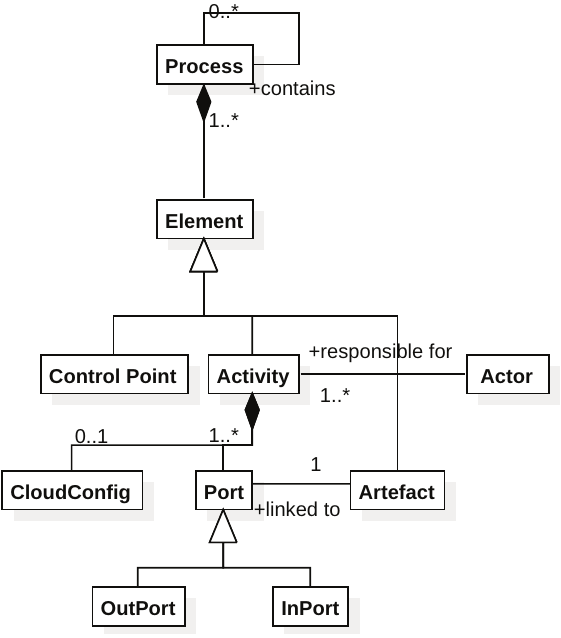
Fig. 2. The XML schema for representing EXE-SPEM pro- cess